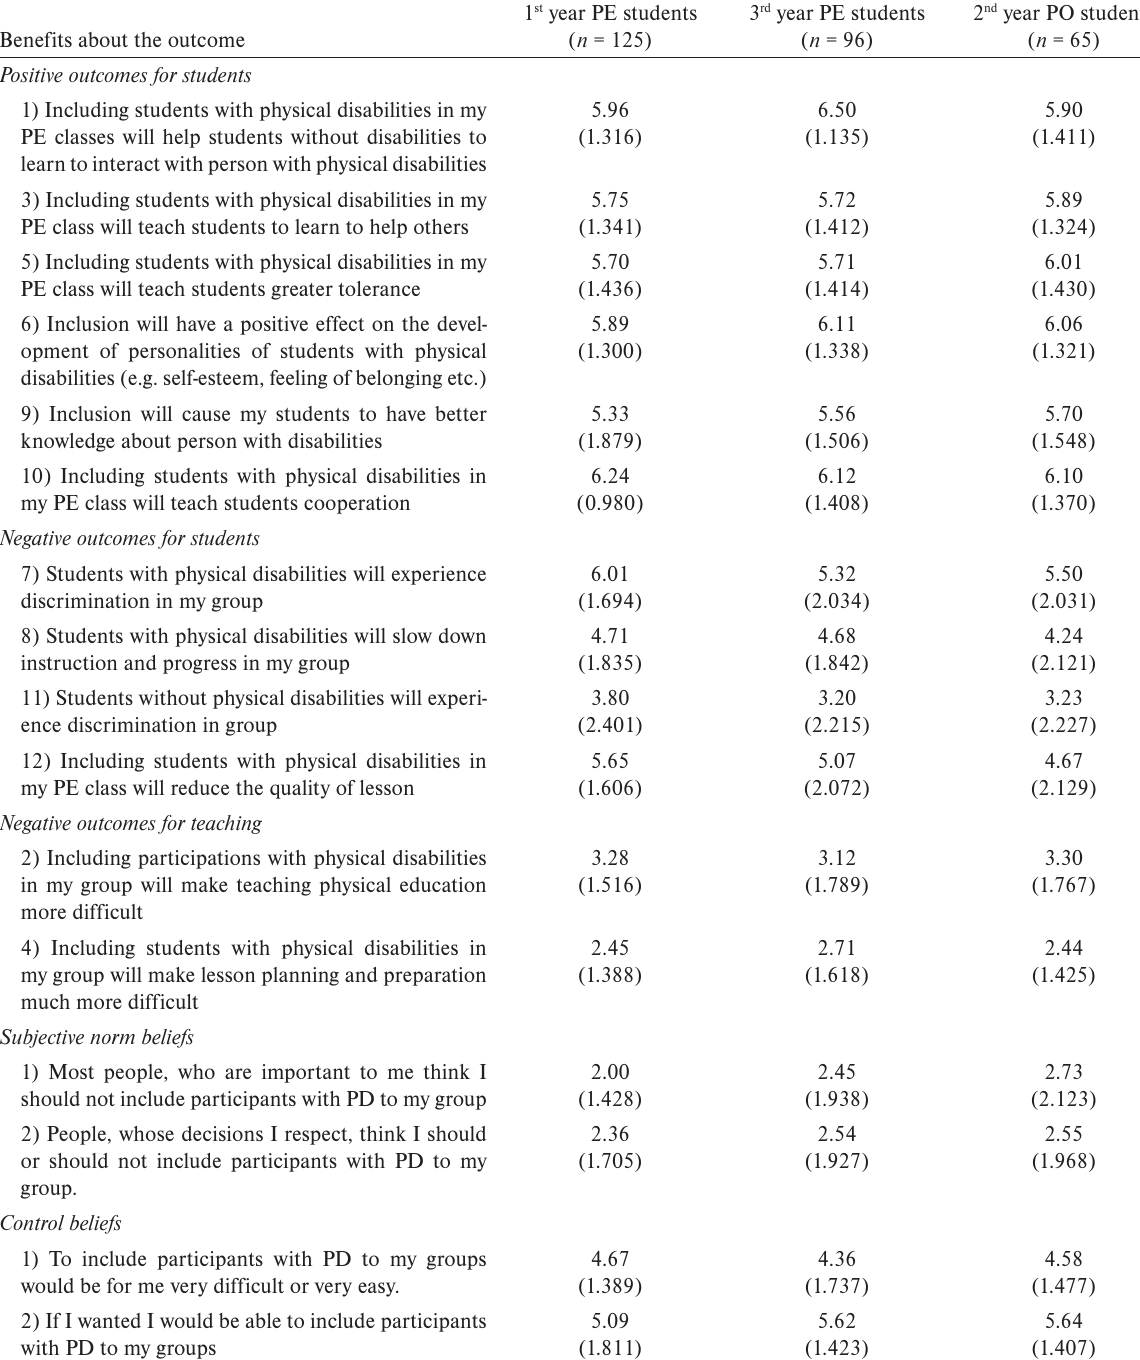
Means (SDs) of behavioural belief scores including individual belief items